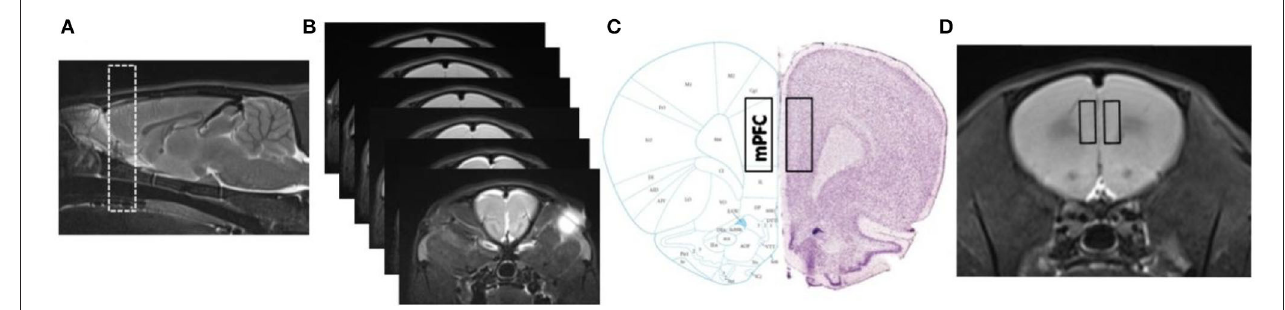
FIGURE 1 | Spatial registration between MR images and histology (Paxinos and Watson, The Rat Brain in Stereotaxic Coordinates, 6th edition). (A,B) Sagittal T2W images and consecutive coronal T2W images of mPFC. Detailed range (rectangles) in mPFC slices and MR images considered for immunofluorescence quantification and texture extraction, as shown in (C,D)